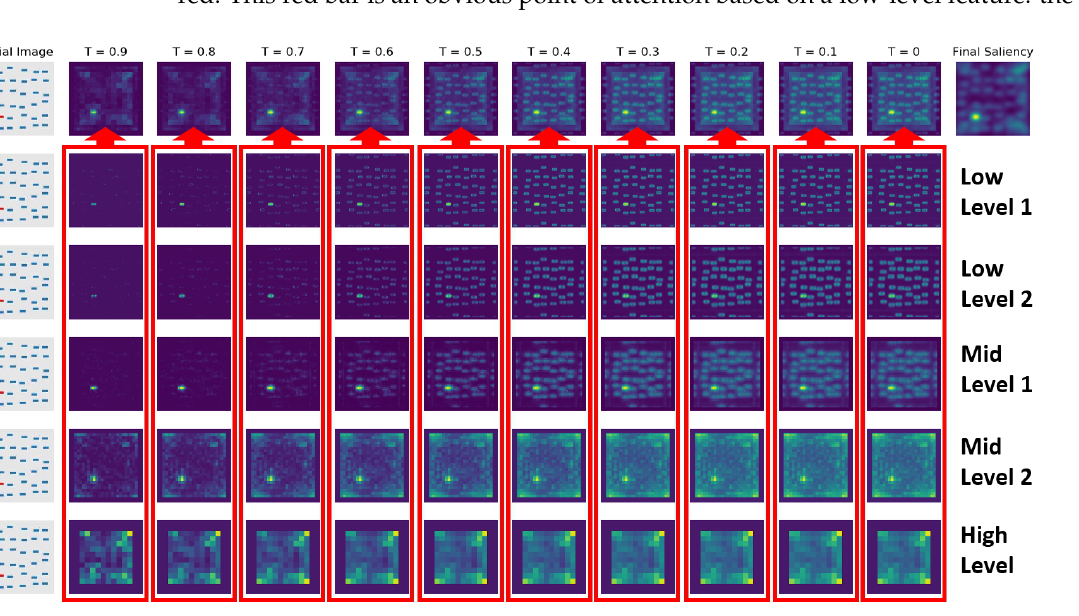
Figure 3. Detailed maps of different levels (from Low Level 1 to High Level) and different thresholds on feature rarity (from 0.9 to no threshold) within the VGG16